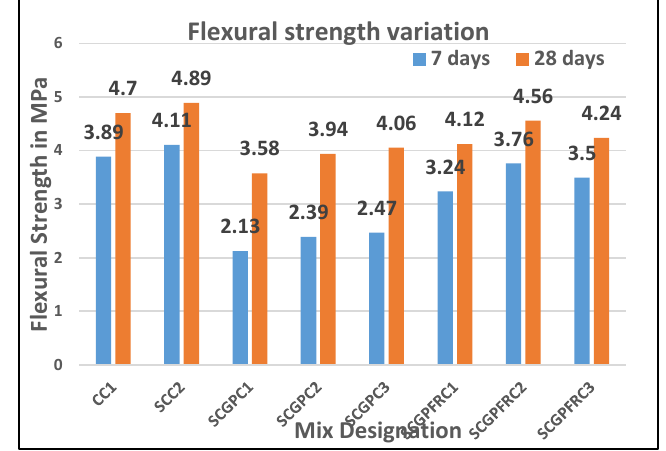
Fig. 12. Graph showing the variation of flexural strength for all mixes.